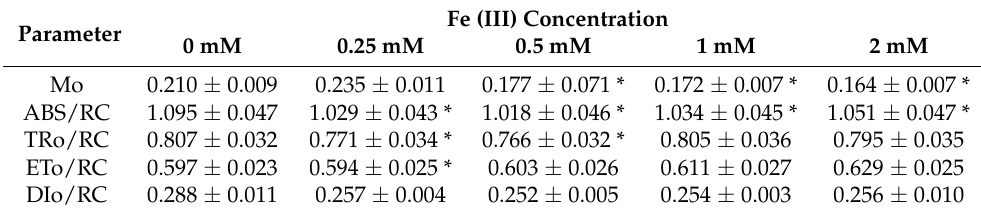
Table 1. Photobiochemical parameters were calculated based on the OJIP-polyphases Chl fluorescence signals for the microalga C. onubensis as a function of the Fe (III) concentration. Mo, net closing rate of RC during illumination; ABS/RC, absorption flux per RC; TRo/RC, trapping energy flux per RC; ETo/RC, electron transport flux per RC; DIo/RC, dissipated energy flux per RC. Fe (III) Concentration Parameter 0 mM 0.25 mM 0.5 mM 1 mM 2 mM Mo 0.210 ± 0.009 0.235 ± 0.011 0.177 ± 0.071 * 0.172 ± 0.007 * 0.164 ± 0.007 * ABS/RC 1.095 ± 0.047 1.029 ± 0.043 * 1.018 ± 0.046 * 1.034 ± 0.045 * 1.051 ± 0.047 * TRo/RC 0.807 ± 0.032 0.256 ±